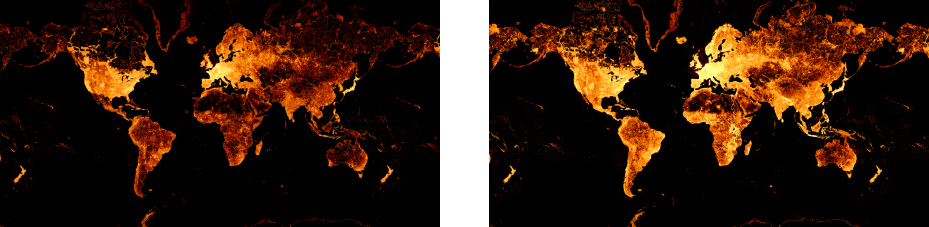
Figure 1. Evolution of the available data provided by OSM. Left : Node density map in 2014. Right : Node density map in